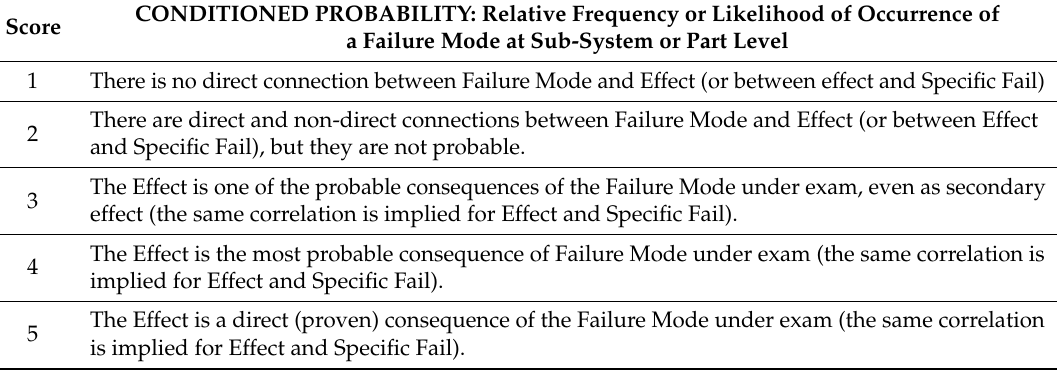
Table 3. Conditioned probability coefficients (both at subsystem and part